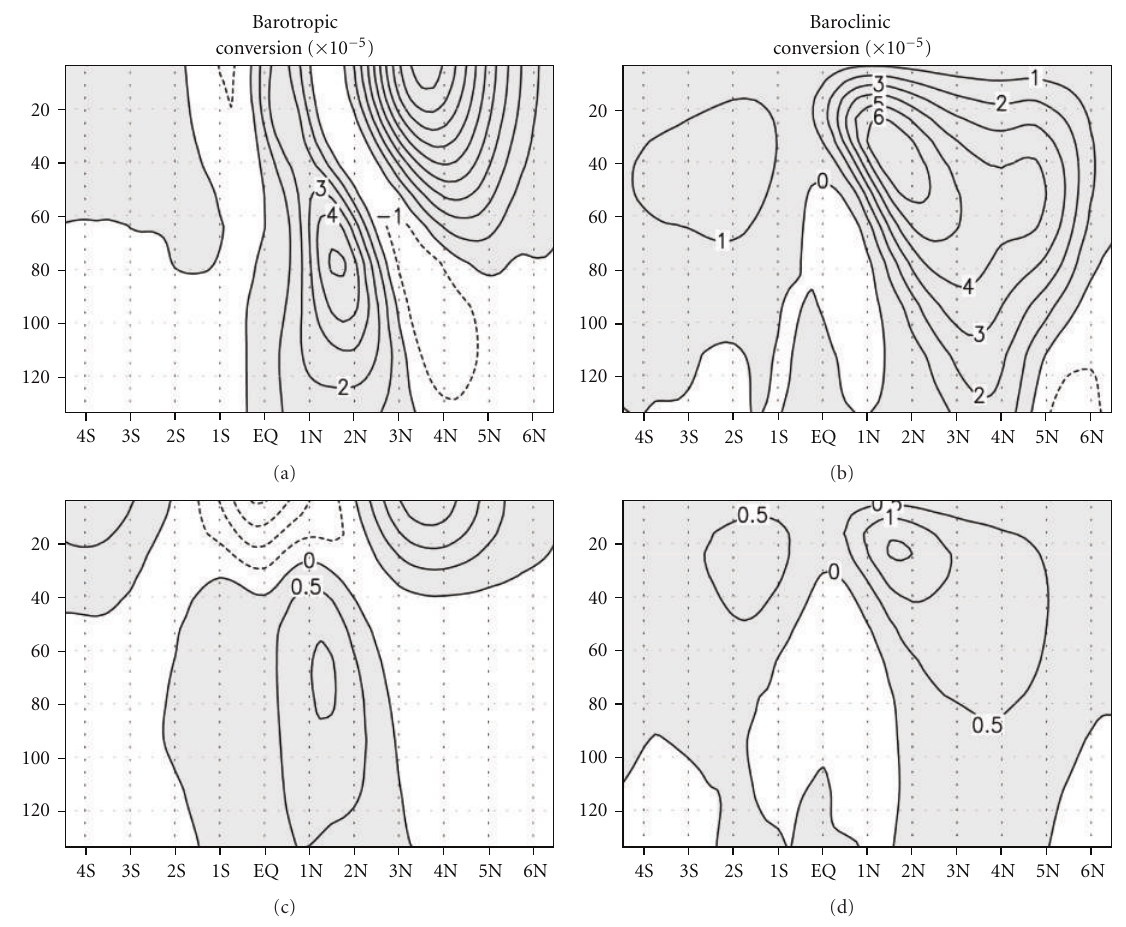
Figure 6: Vertical distributions of zonal mean barotropic ((a), (c)) and baroclinic ((b), (d)) conversions averaged from June to September (a) and (b) and from March to April (c) and (d). Units are W/m 3 . Positive values are shaded.